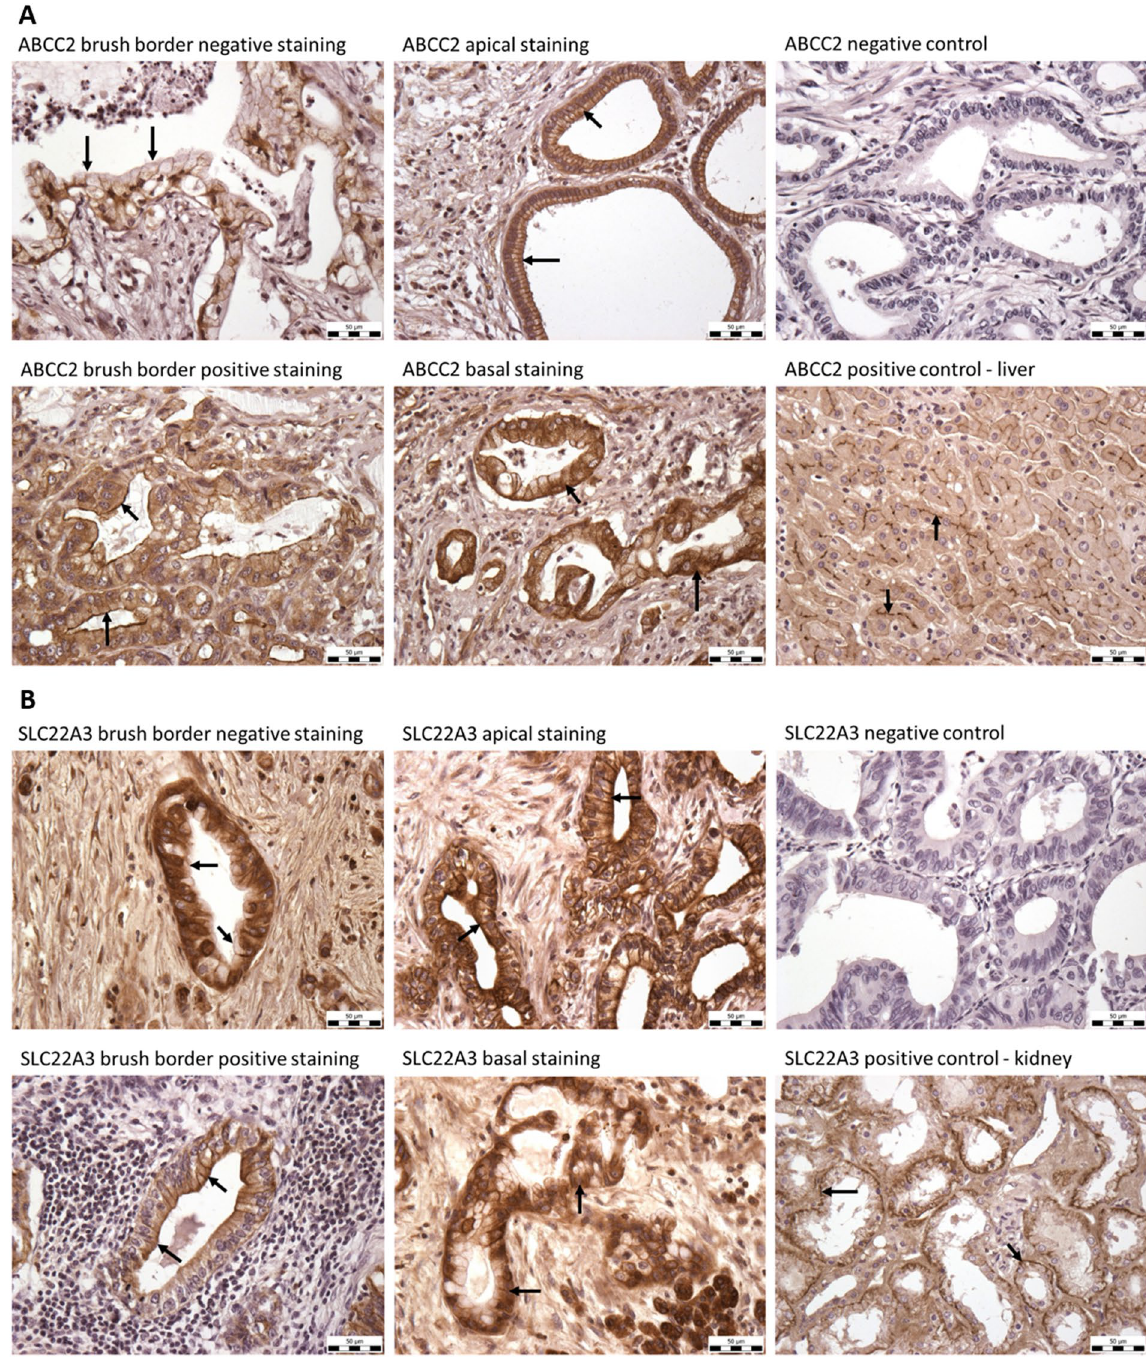
Figure 1. Immunohistochemistry of the ABCC2 and SLC22A3 transporters. ( A ) Examples of ABCC2 negative and positive brush border staining, apical and basal staining, and negative and positive controls. Negative control: tumor tissue stained without primary antibody. Positive control: human kidney cortex. ( B ) Examples of SLC22A3 negative and positive brush border IHC staining, apical and basal staining, and positive and negative controls. Negative control: tumor tissue stained without primary antibody. Positive control: human liver. Arrows allow easier visual control of results. Scale bar 50 µ